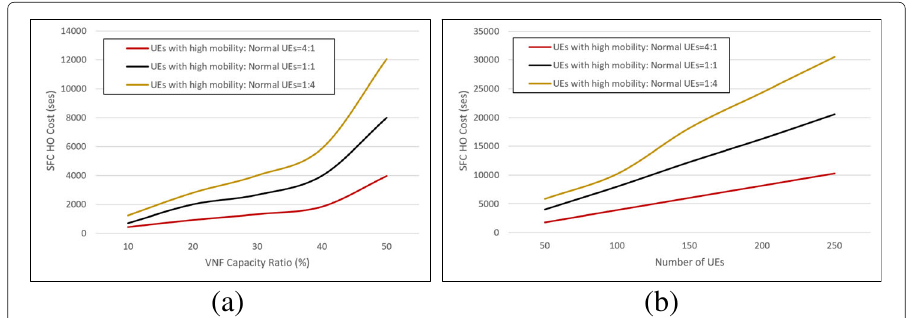
Fig. 6 The impacts of the different proportion of the UE on the SFC HO costs. This is the results of the experiments about the impacts of the different proportion of the UE on the SFC HO costs. The SFC HO cost meant the time that it took for all services to restore in the blockage, while the VNF capacity ratio meant the proportion of the storage of each VNF in the storage of total MEC server. In these experiments, we set the proportion of the UE of high mobility and the ordinary UE as 4:1, 1:1 and